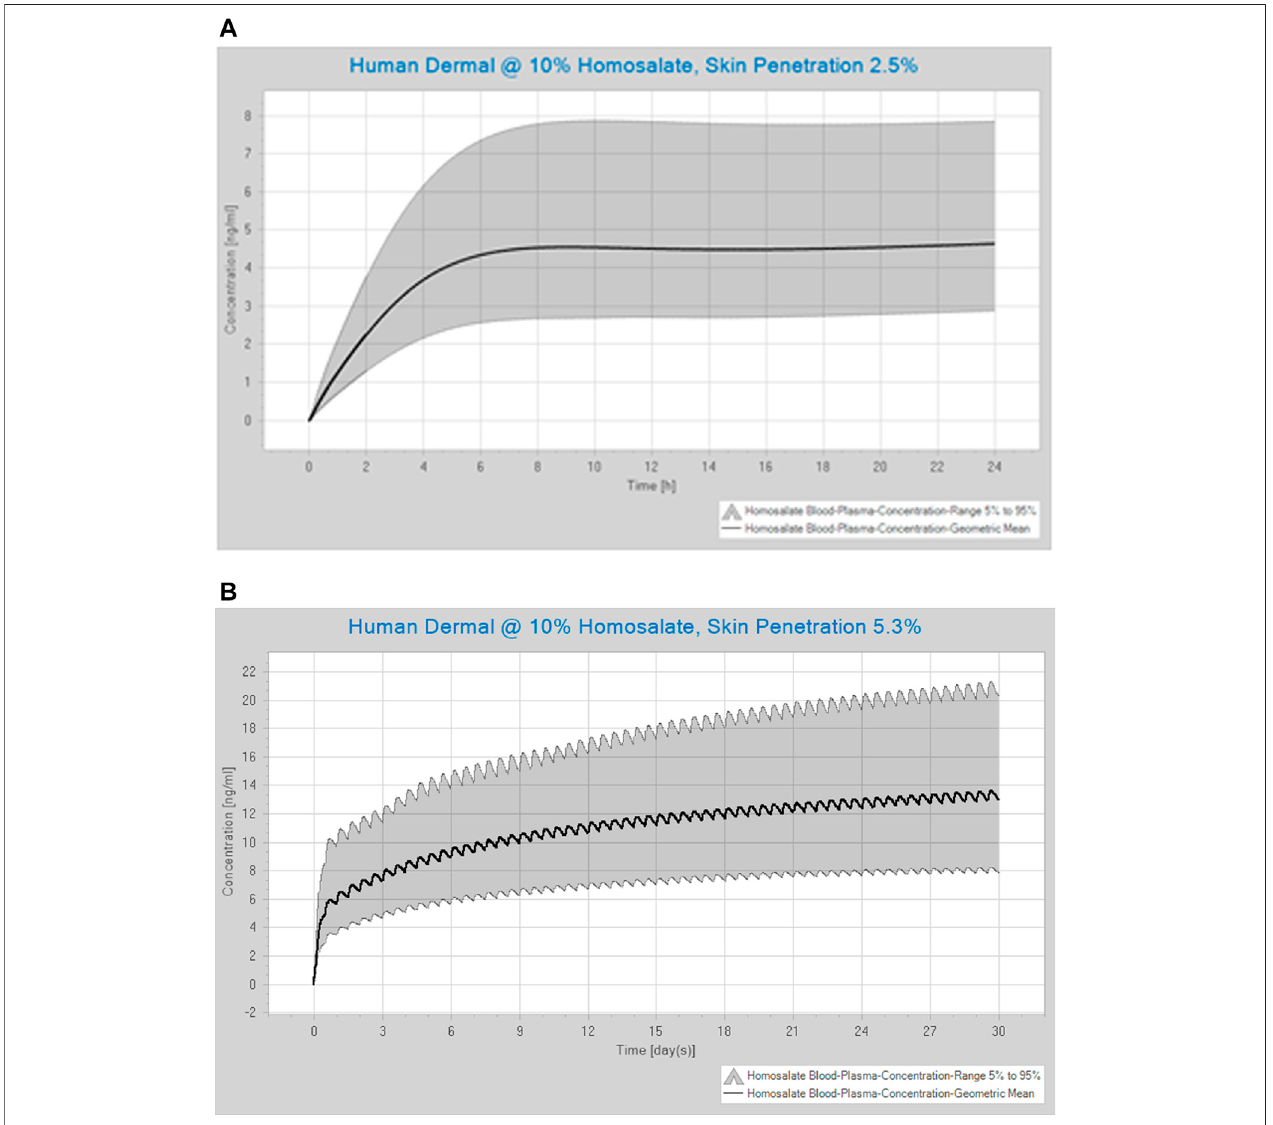
FIGURE 4 | Simulated concentration-time pro fi le of homosalate (A) over 24 h after a single application, where the dermal penetration was estimated to be 2.5% (this scenario mimics that tested by Matta et al. (2020)), and (B) over 30 days of repeated dermal exposure, where the dermal penetration was estimated to be 5.3% of theapplieddose(thisscenariomimicsthedosingforthesafetyassessment).ValuesareshownforthemeanandtheCI(5 – 95)%.Theapplicationwasof10%homosalate applied to the human whole-body.